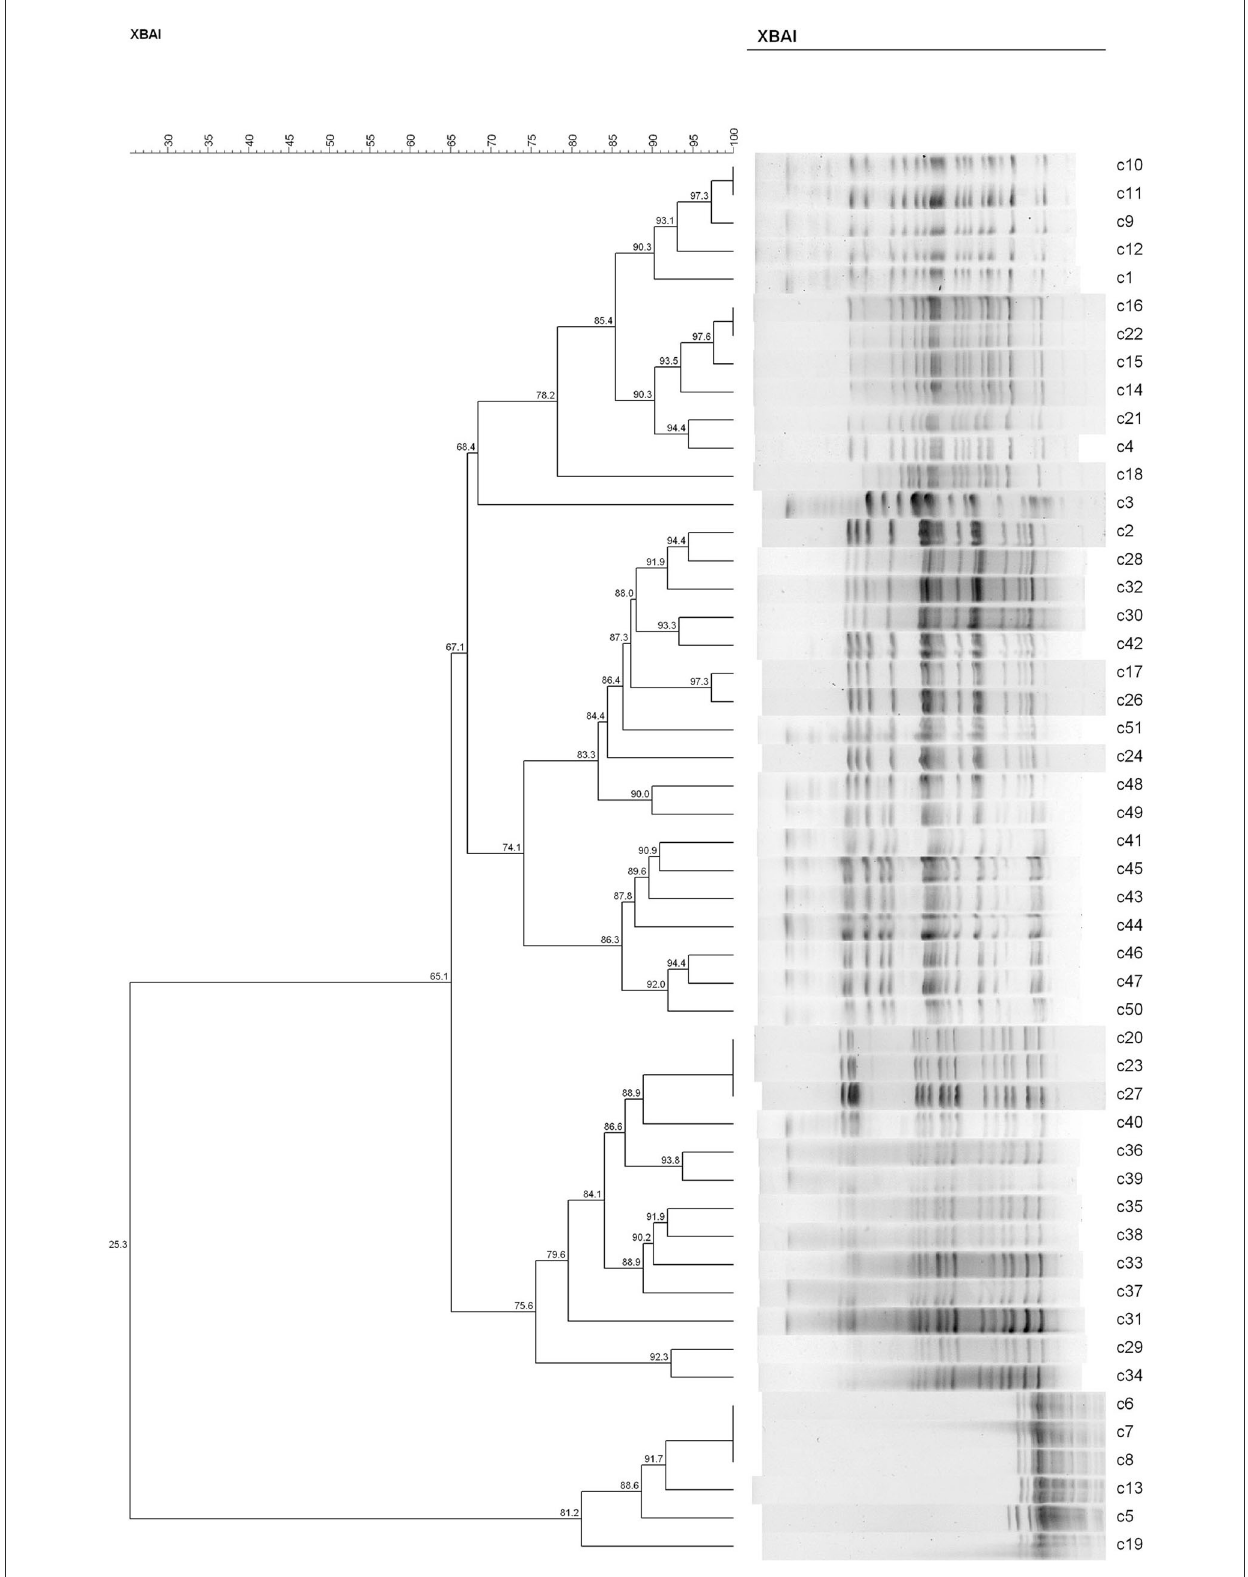
FIGURE5 The PFGE of cefotaxime-sensitive or resistant isolates from one rat’s fecal samples in H − group. Numbers c1–c31 indicate indigenous sensitive E. coli isolates; numbers c32–c51 indicate bla CTX − M -positive E. coli isolates.